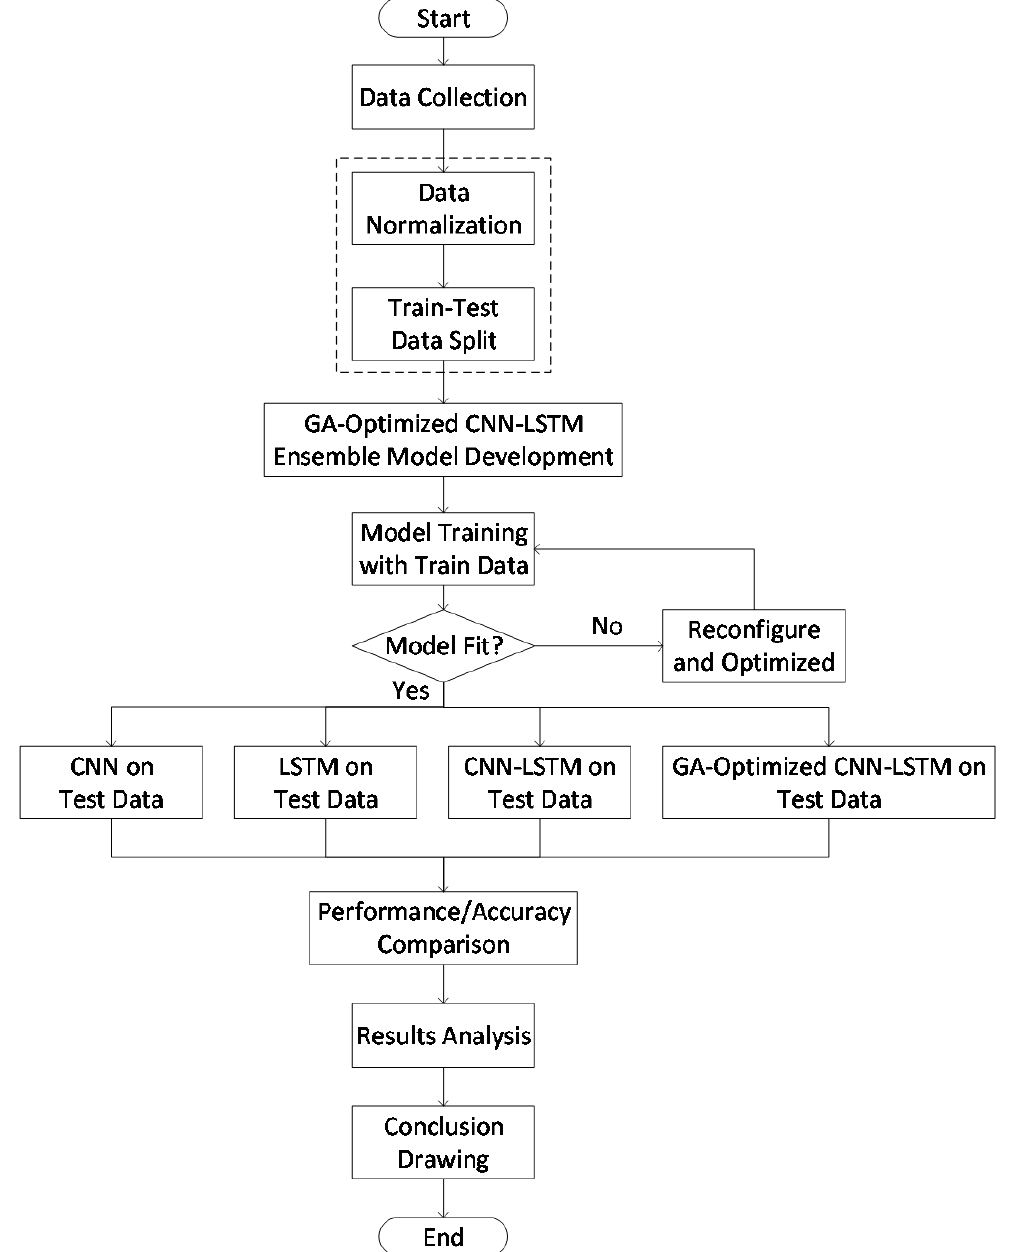
Figure 4. Constructive research methodology applied in the